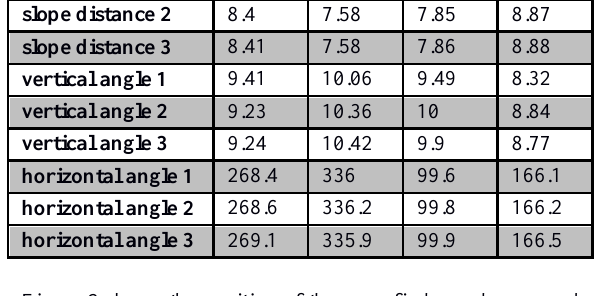
Figure 4: Point cloud data collected by Leica scanstation C10. Room 10 is our test case and room 1 is our reference (see Figure 5).